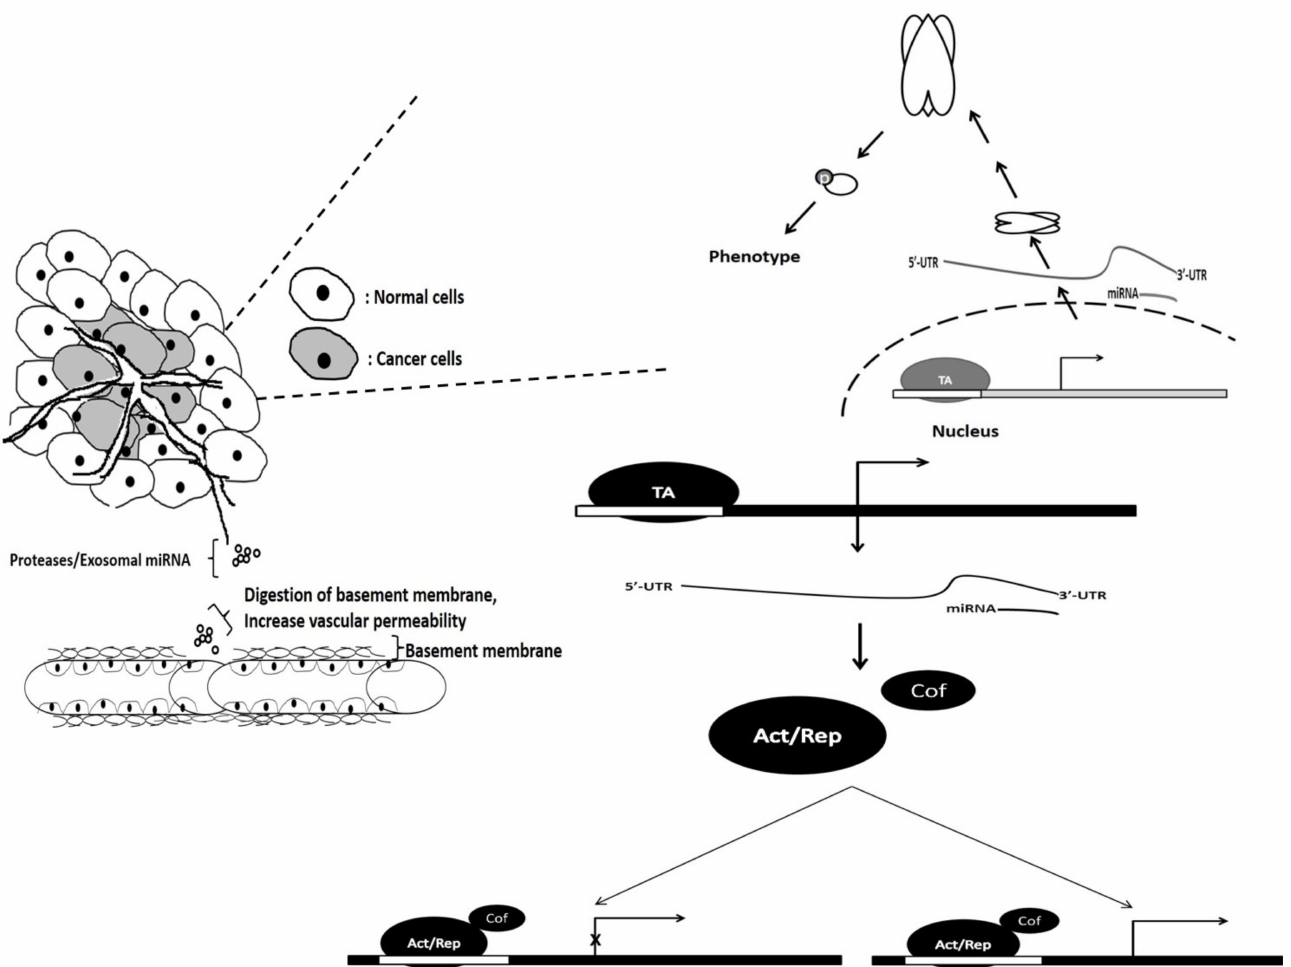
Figure 7. The microRNA-regulation-targeting genes involved in cancer angiogenesis, which occurs at the proteomic, genomic, exosomic and phenotypic levels. Act/Rep: Activator/repressor, Cof: Cofactor, miRNA: micro-RNA, UTR: untranslated region, TA: transcription activator, P: phosphate